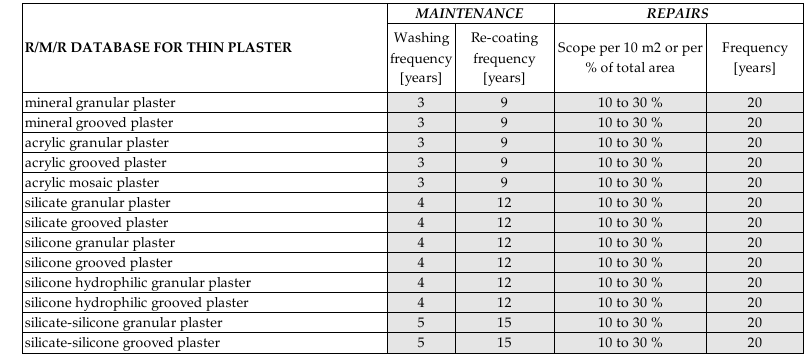
Figure 4. R / M / R database for the LCC calculation of the individual variants (thin Figure 4. R/M/R database for the LCC calculation of the individual variants (thin plaster).